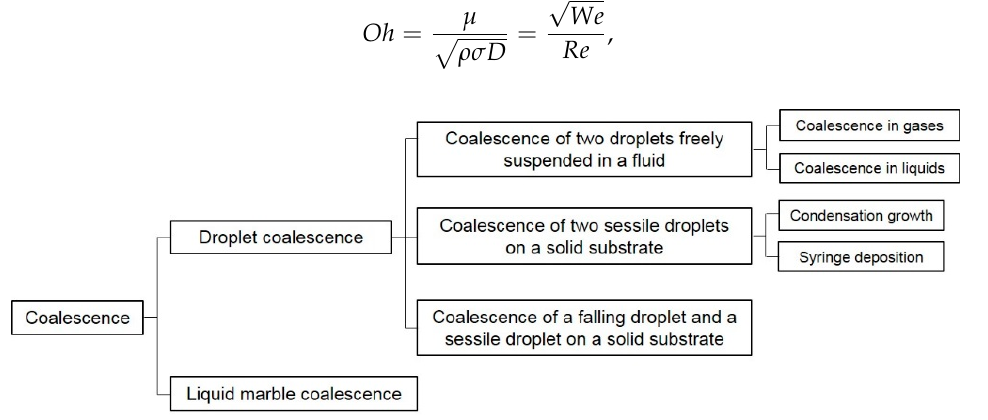
Figure 2. The coalescence systems reviewed in this paper.